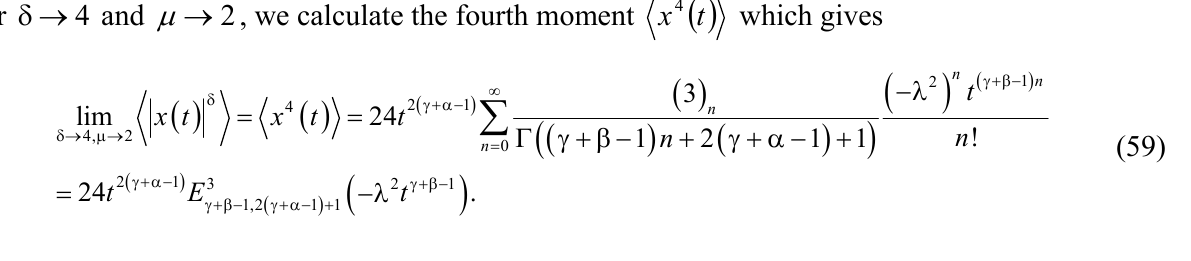
Figure 2. Graphical representation of second moment (57) for 1  